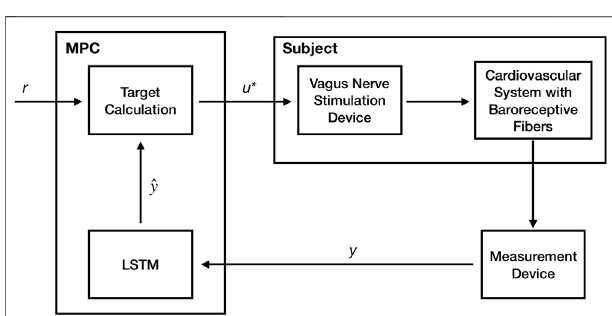
FIGURE 2 | A Schematic showing our model-based predictive closed- loop optimal control framework for optimizing the vagus nerve stimulation (VNS)parameterstocontrolmultiplecardiacphysiologicalbiomarkerssuchas heart rate (HR) and mean arterial blood pressure (MAP). Here, a long short-term memory (LSTM) based recurrent neural network model has been usedtomakepredictionsofHRandMAPinresponsetoVNSandoptimizethe VNS parameters within the model predictive control (MPC)